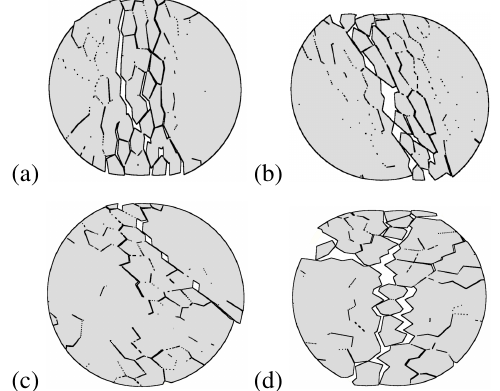
Figure 3. Evolution of the failure mechanism as the loading ori- entation increases (a) ✓ = 0  , (b) ✓ = 30  ,(c) ✓ = 60  and (d) ✓ = 90  for the sample with inherent anisotropy ⌘ = 2.